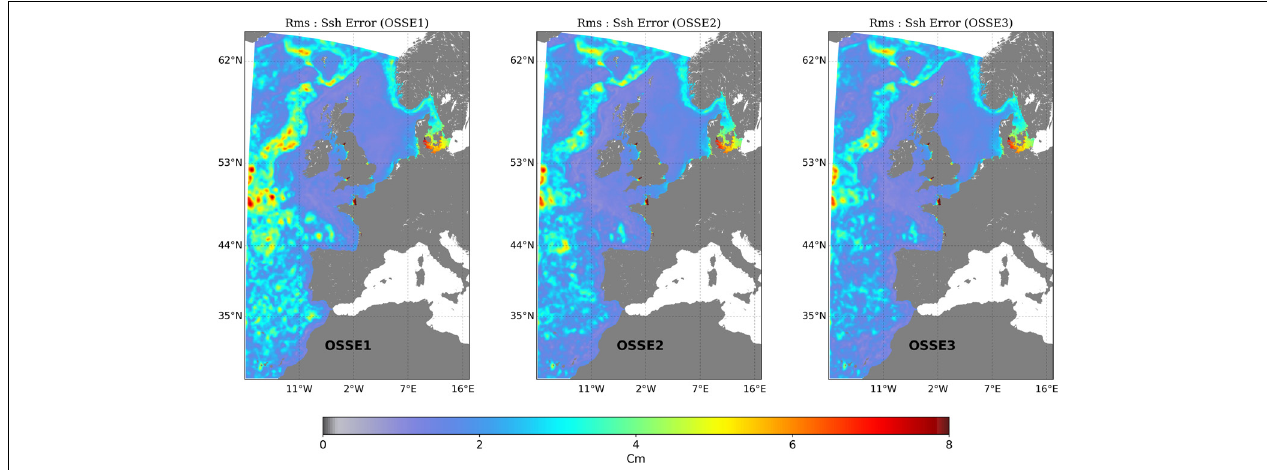
FIGURE 11 | Map of the SSH analysis rms error over the IBI domain during 2009 (in cm). Results were obtained by comparing the analyzed SSH in the experiments OSSE1 (three nadir altimeters), OSSE2 (SWOT), and OSSE3 (SWOT + three nadir altimeters) with the data of the NatRun ( Credits: Mercator Ocean ).